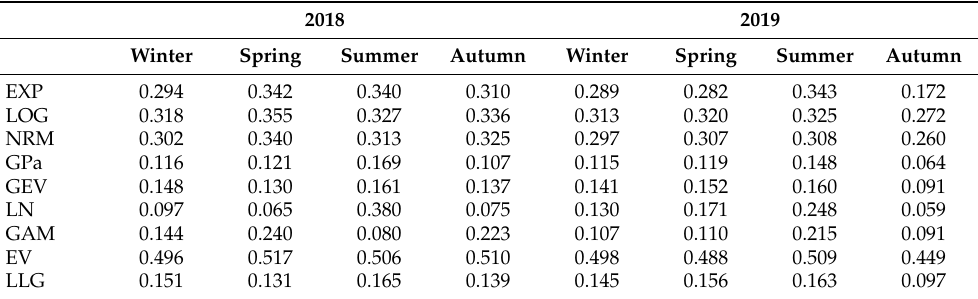
Table 6. KS-test results for the L-moment estimation, and for the 2000 m